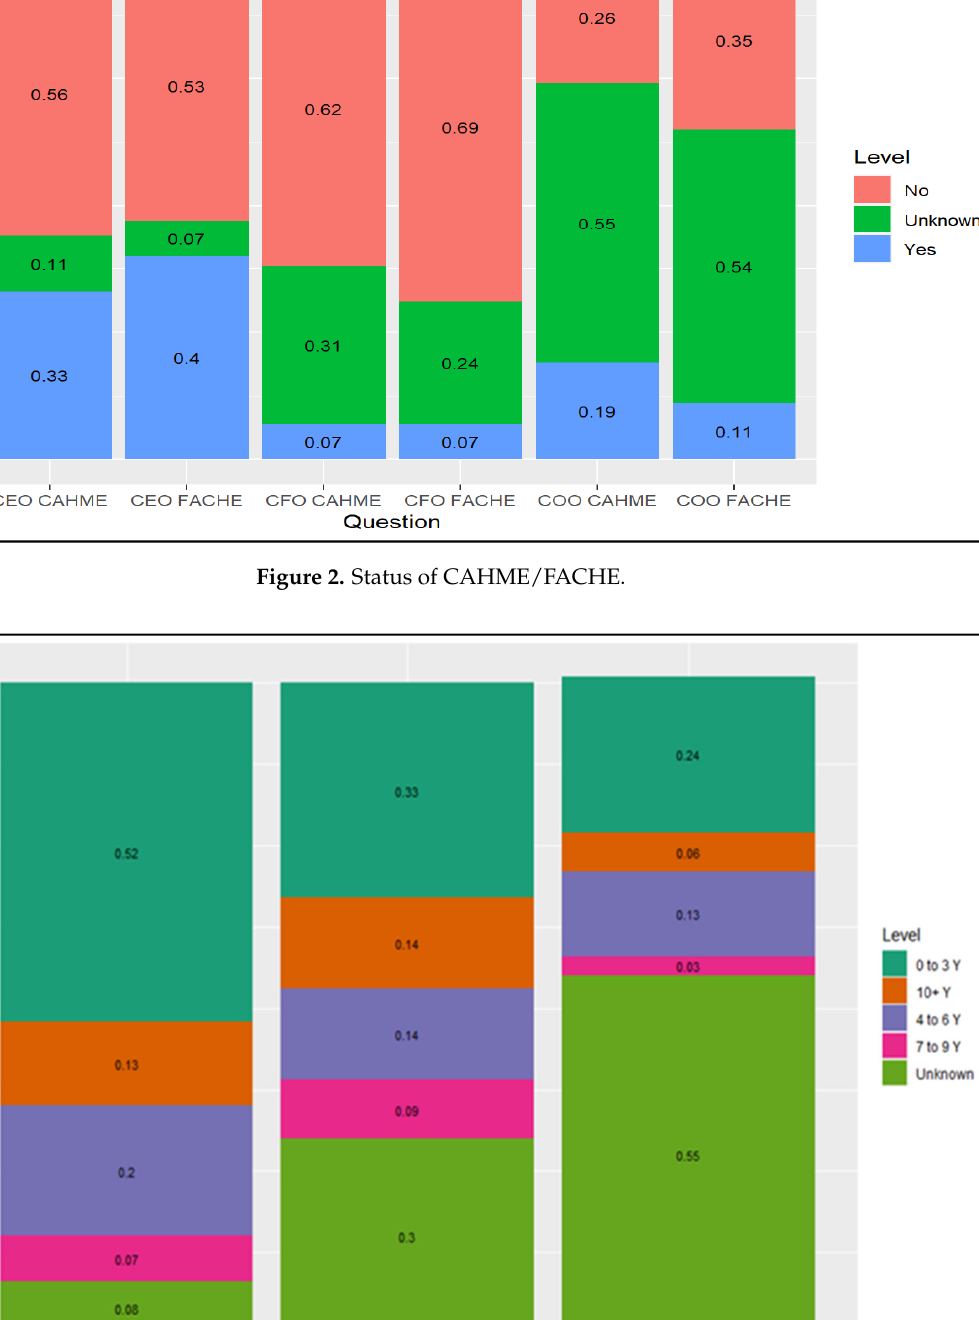
Figure 1. Scatterplot, bivariate plot, and univariate plots of the dependent variables.